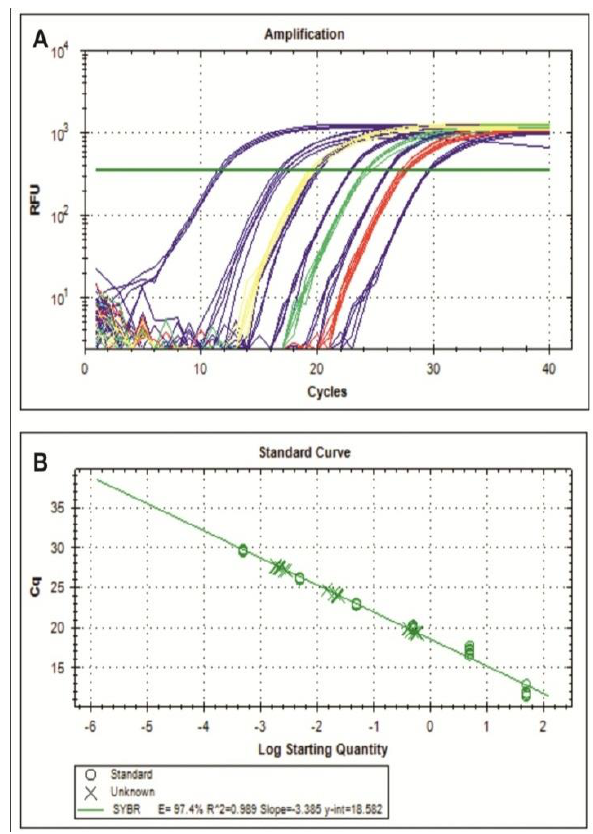
Figure 2. Real-time PCR amplification. A) Typical amplification plot of qPCR to determine mean threshold cycle (C ) values. Blue line: serial dilutions of PepGMV t